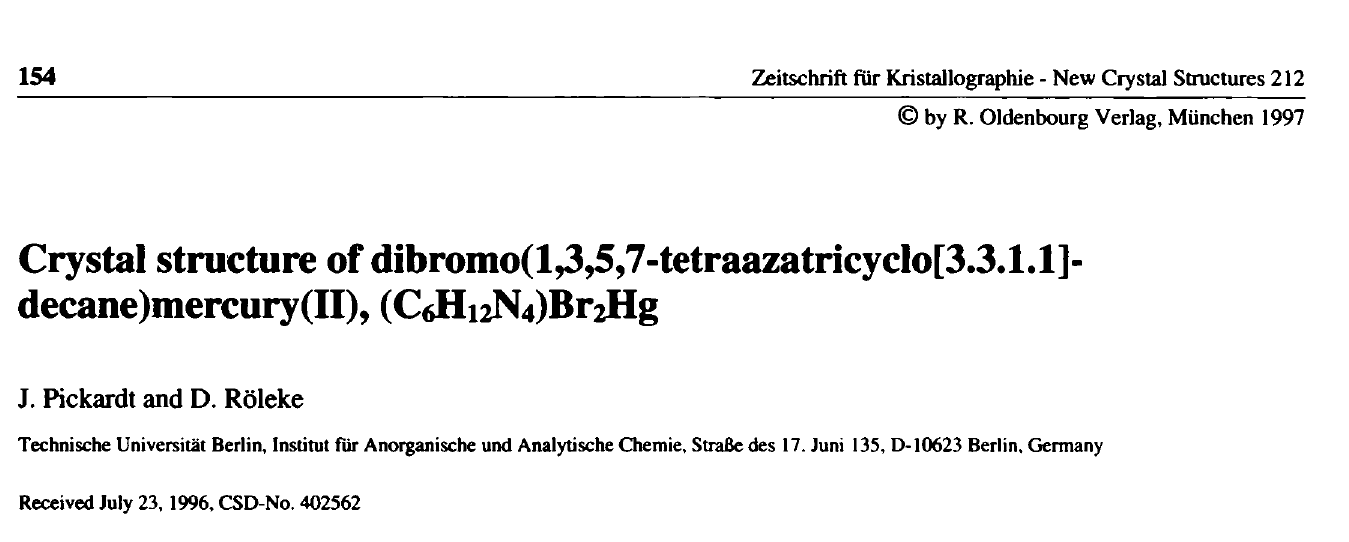
Table 1. Parameters used for the X-ray data collection Crystal: